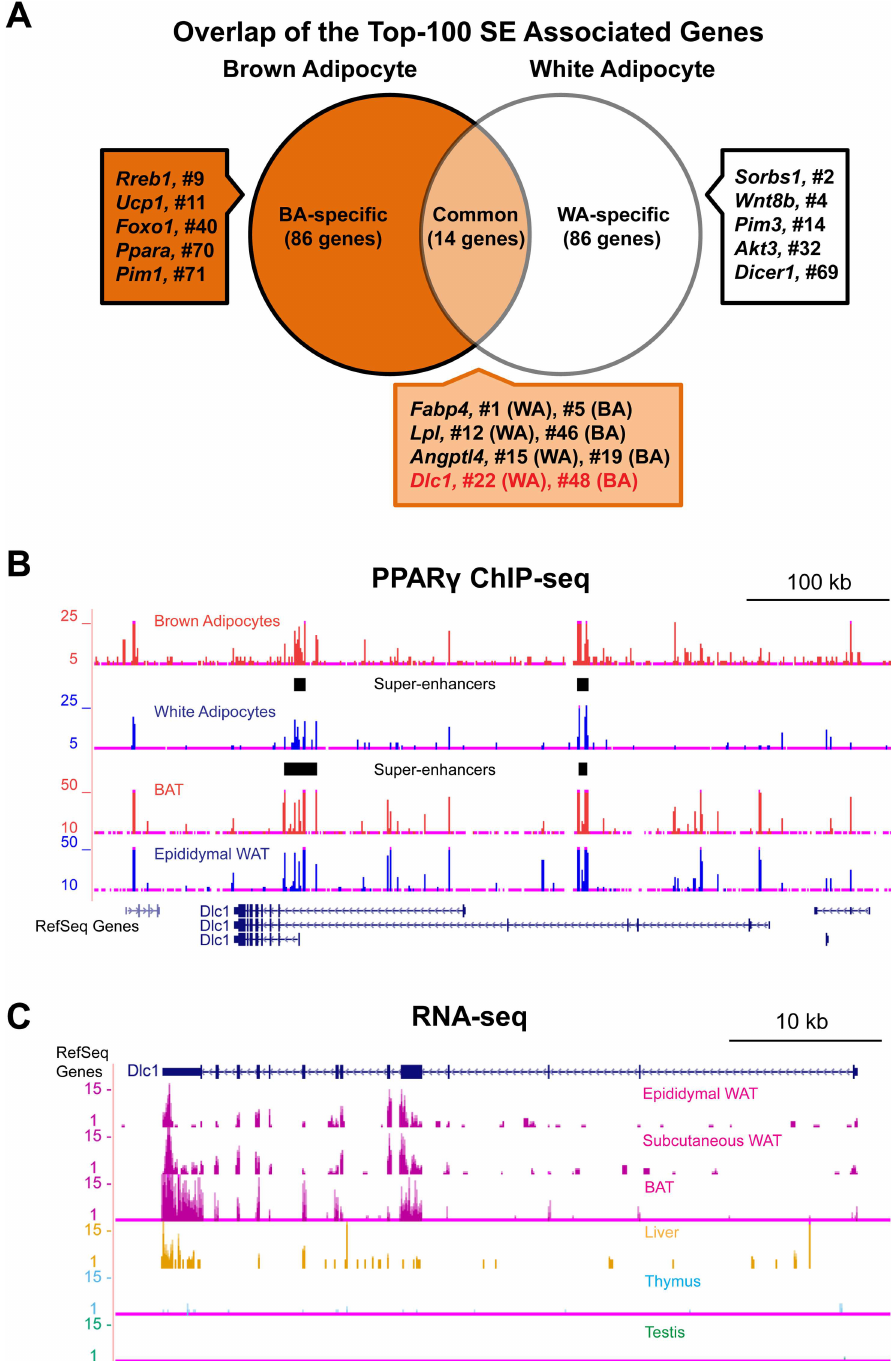
Fig 1. Dlc1 is Associated with PPAR γ Defined Super-enhancers in both White and Brown Adipocytes. (A) Venn diagramshowingthe overlap of the Top-100 super-enhancer associated genes in both white and brown adipocytes.Genome-wide bindingprofiles of PPAR γ were used to defineSEs. Representative SE associated genes with their ranks in the corresponding lineageswere shown. (B) PPAR γ bindingpeaks and their definedSEs at the Dlc1 gene locus in brown adipocytes, white adipocytes, brown adiposetissue and epididymal white adiposetissue. (C) ENCODE RNA-seq data showingthe expressionof Dlc1 gene in various mouse